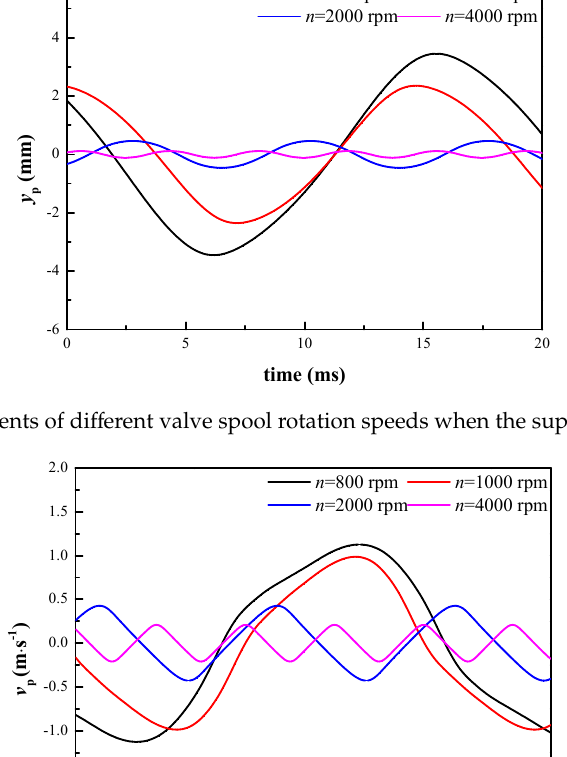
Figure 9. Accelerations of different valve spool rotation speeds when the proportional flow control valve port is fully open.